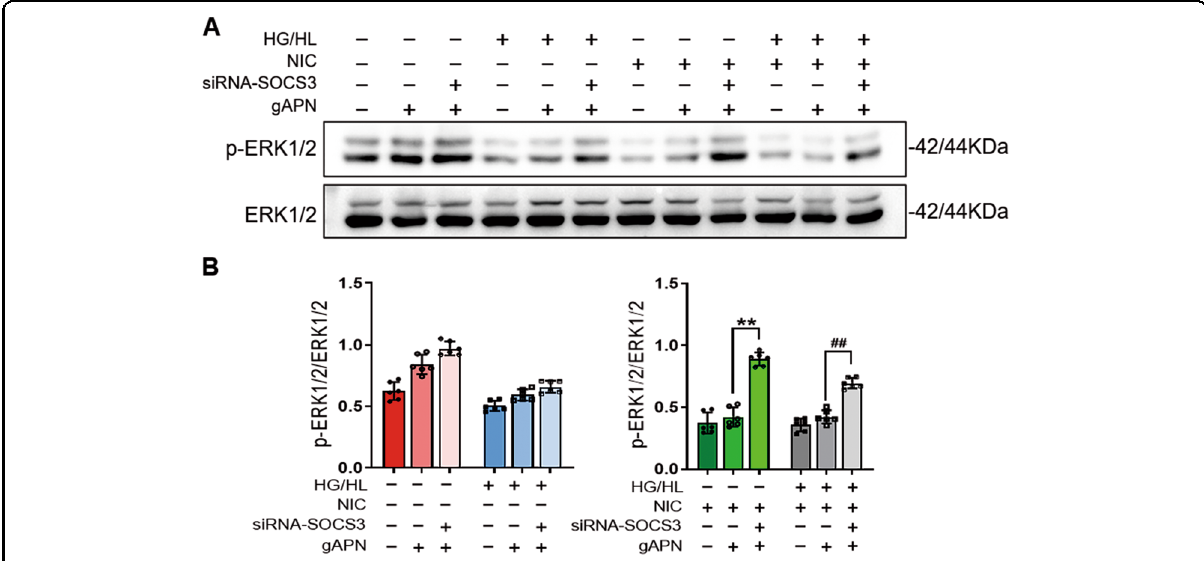
Fig. 6 SOCS3 de fi ciency restored APN activation of ERK1/2 that was suppressed by NIC and NIC + HG/HL. A Western blot detected the level of phosphorylation of ERK1/2. B Quanti fi cation of the density of ERK1/2. n = 6 dishes/group. ** P < 0.01 vs. NIC + gAPN group; ## P < 0.05 vs. NIC + HG/ HL + gAPN group. Data were analyzed by two-way ANOVA. NIC, nicotine; HG/HL, high glucose/high lipid; gAPN, globular